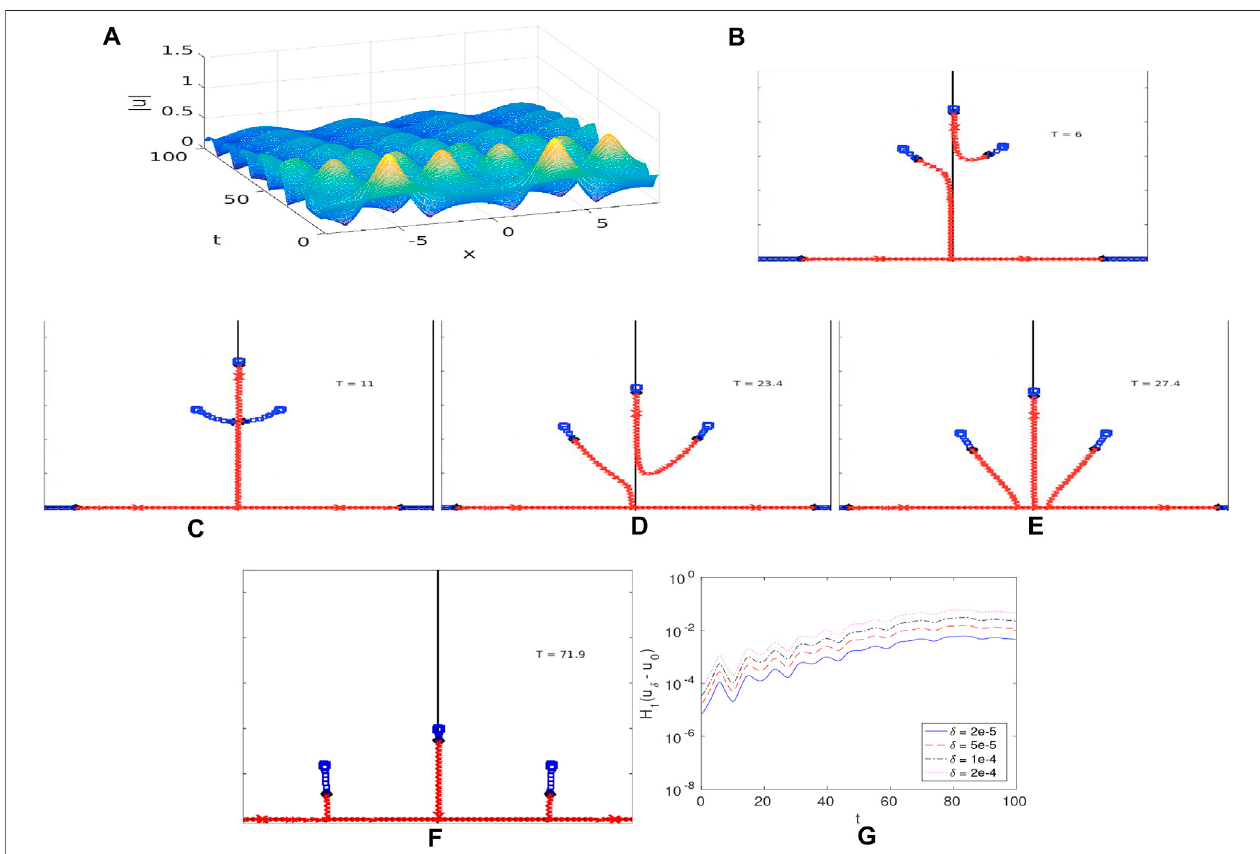
(cid:12)(cid:12)(cid:12)(cid:12)(cid:12) (cid:12)(cid:12)(cid:12)(cid:12)(cid:12) U ( 2 ) ε , c ( x , t ) for 0 ≤ t ≤ 100 and Spectrum at (B) t (cid:1) 6, (C) t (cid:1) 11, (D) t (cid:1) 23 . 4, (E) t (cid:1) 27 . 4, (F) t (cid:1) 71 . 9, and (G) η ( t ) for f 1 ( x , t ) ,